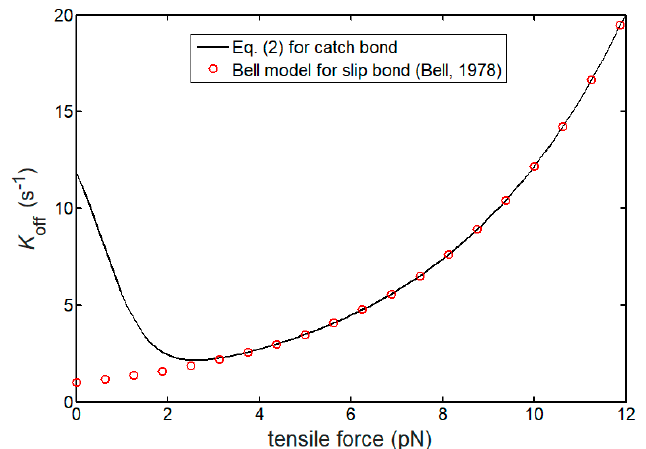
Figure 6. Dissociation rate of catch ( black line ) and slip ( red cycles ) bonds versus tensile force. The red cycles represent the theoretically predicted results for slip bond from the Bell model [7].